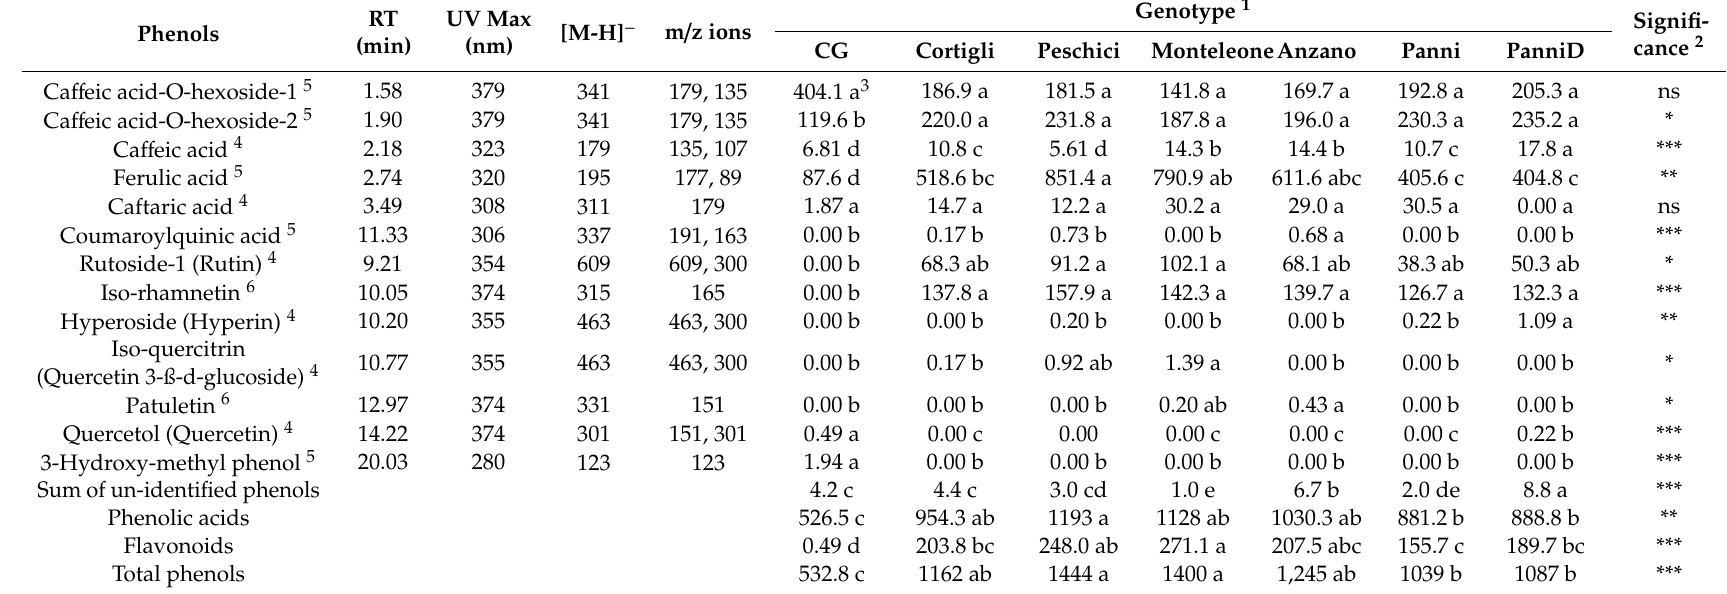
Table 5. Phenolic compounds (mg kg − 1 dw) in the bulb of garlic